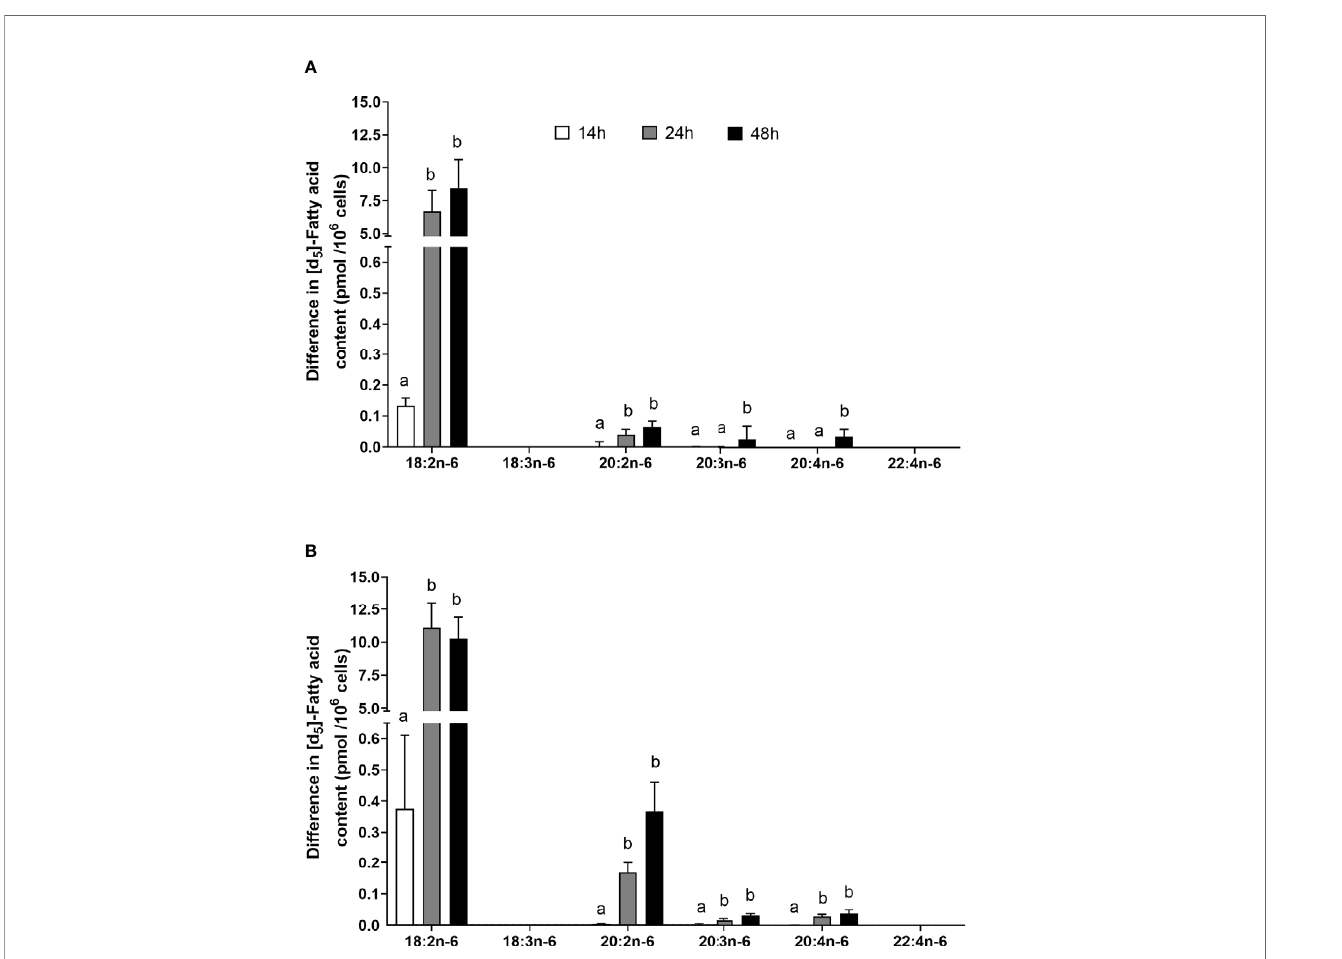
FIGURE 5 | The effect of duration of incubation and essential fatty acid (EFA) ratio on the mitogen-induced change in the amount of [d 5 ] n-6 polyunsaturated fatty acids (PUFAs) in CD3 + T cells. Values are mean ± SEM (n = 10/time point) change in the amount of labelled longer-chain PUFA (LCPUFA) after 14-, 24-, and 48-h incubation in media containing an EFA ratio (18:2n-6:18:3n-3) of (A) 5:1 or (B) 8:1. Means represented by bars with different letters were signi fi cantly different by two-way ANOVA with Tukey ’ s post-hoc test. Results of statistical analyses are shown in Table 4 .